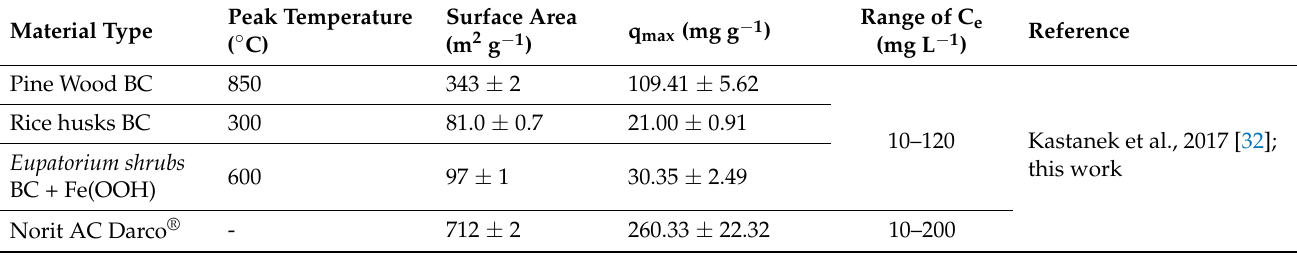
Table 4. Characteristics of various Biochar and commercial Activated Carbon studied and the maximum TCE adsorbed per grams of material (according to the Langmuir